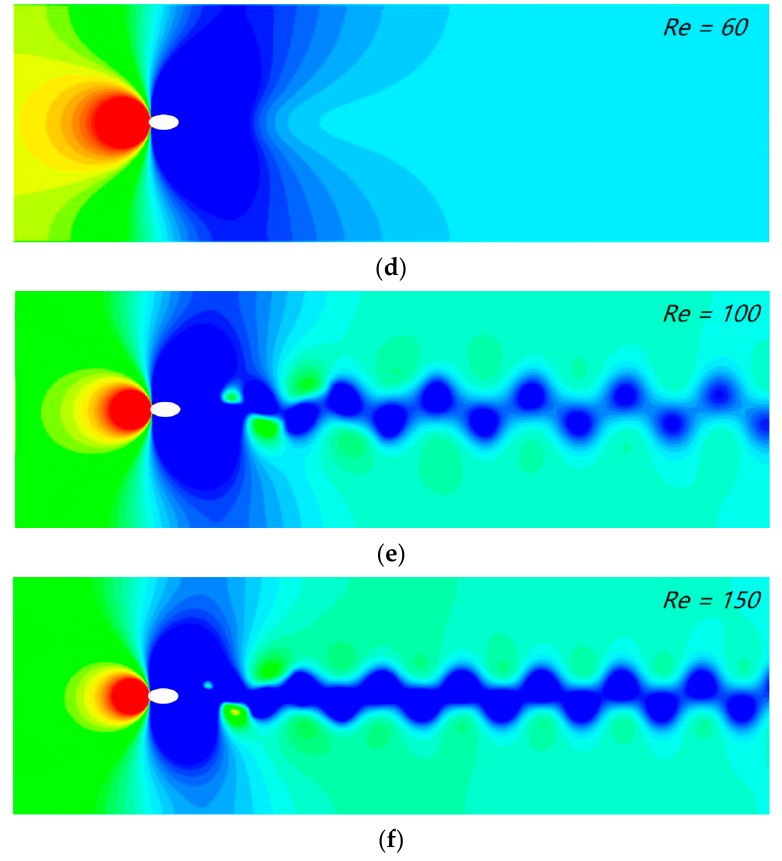
Figure 16. Instantaneous vorticity contours surrounding the elliptical cylinder at various Reynolds numbers: ( a ) Re = 60, ( b ) Re = 100 and ( c ) Re = 150; instantaneous pressure contours surrounding the elliptical cylinder at various Reynolds numbers: ( d ) Re = 60, ( e ) Re = 100 and ( f ) Re = 150.